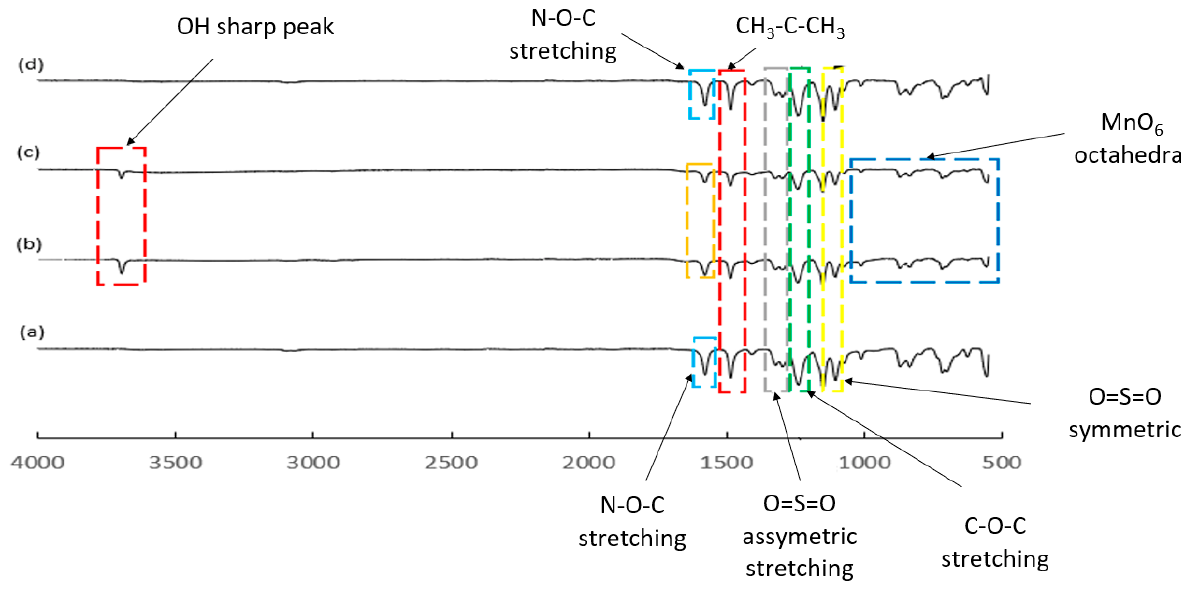
Figure 5. FTIR spectra of ( a ) PES 0, ( b ) PES 1, ( c ) PES 3, and ( d ) PES 5 membranes.